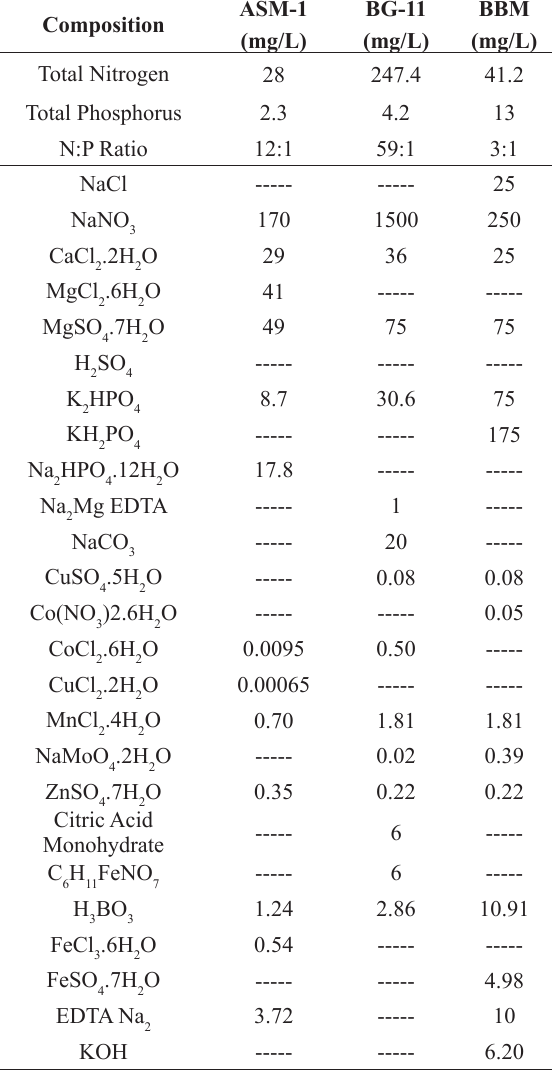
Figure 1 - Composition of the culture media ASM-1, BG-11 and